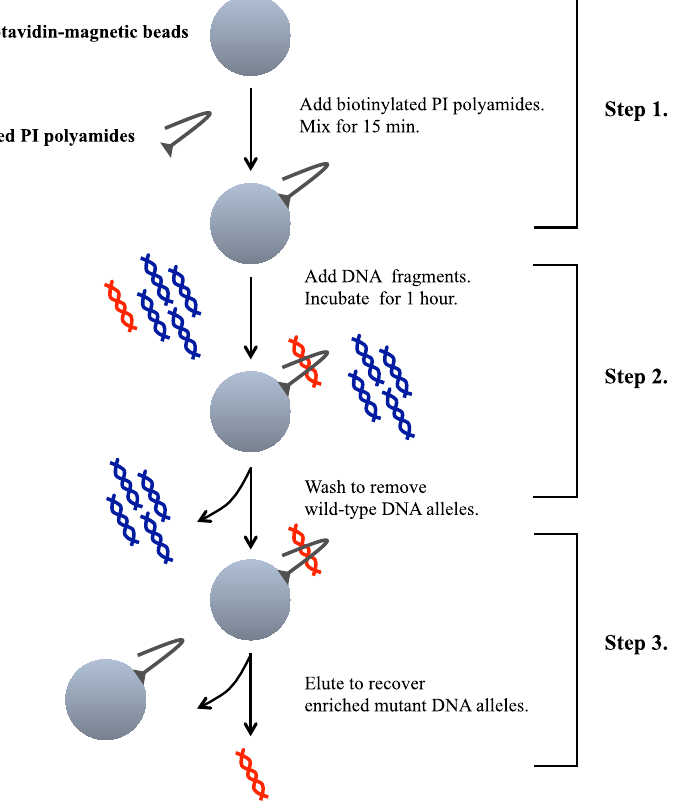
Figure 4. Schematic representation of the enrichment assay using biotinylated pyrrole–imidazole